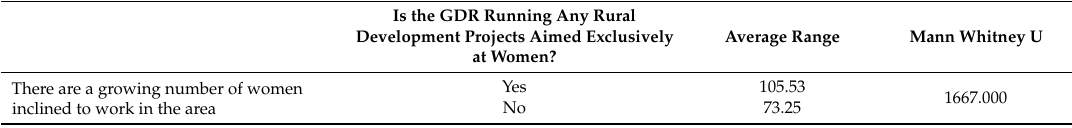
Table 5. Results of the non-parametric Mann Whitney U test for two independent samples.